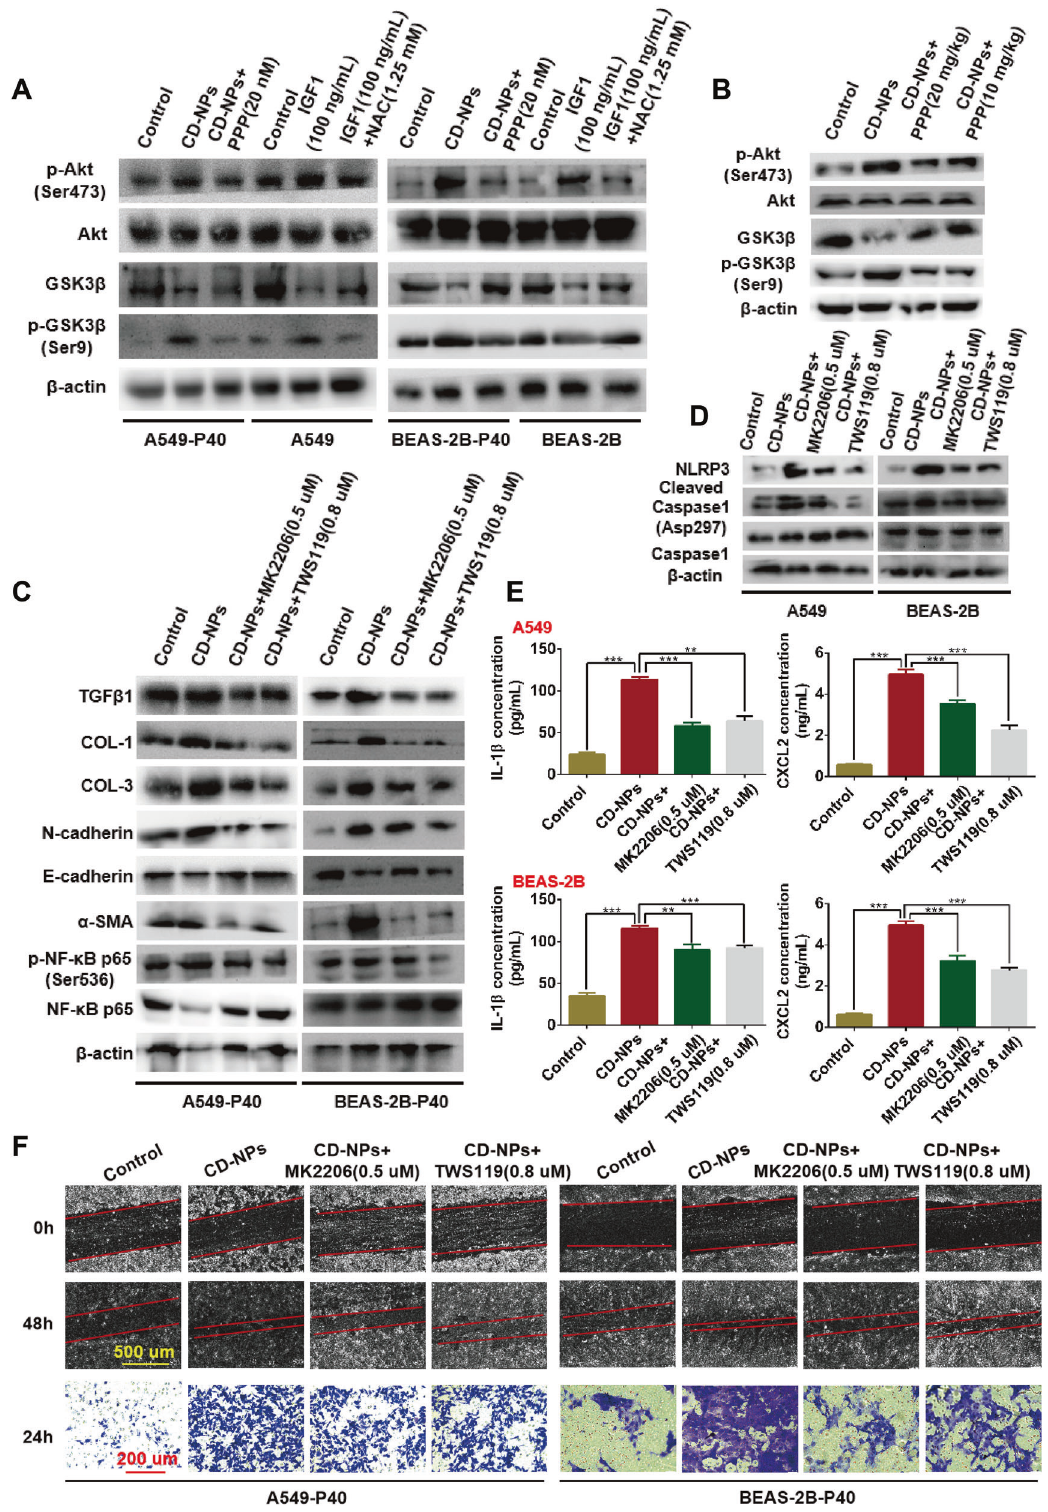
Fig. 8 ROS-mediated AKT/GSK3 β signals drive NF- κ B/NLRP3 pathway to promote in fl ammation and EMT. A , B The activation level of AKT/ GSK3 β pathway was detected by western blot in vitro and in vivo. C , D The expression levels of EMT marker molecules (N-cadherin, E-cadherin and TGF β 1), in fl ammatory pathway protein molecules (NLRP3, Cleaved Caspase1/Caspase1) and fi brosis marker molecules (COL-1, COL-3 and α -SMA) was detected by western blot. E In fl ammatory factor IL-1 β and in fl ammatory chemokine CXCL2 the supernatant of alveolar epithelial cells were detected by ELISA. Data were expressed as the mean ± SD, n = 3. ** P < 0.01 and *** P < 0.001. F The migration and invasion abilities of alveolar epithelial cells were detected by scratch healing assay and transwell assay.